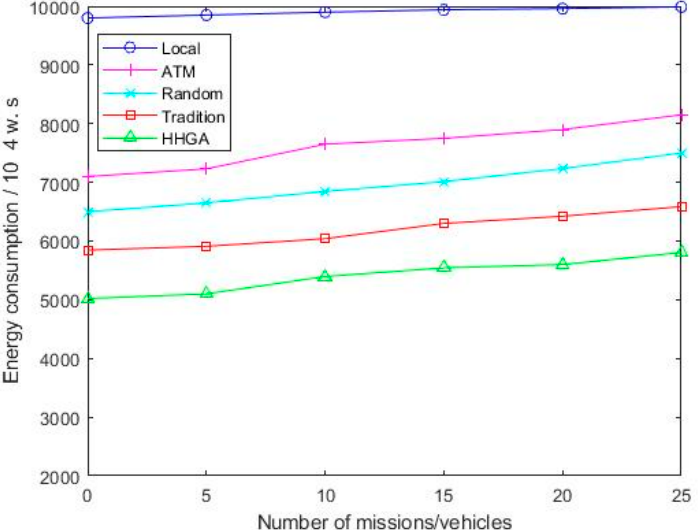
Figure 6. Comparison of energy consumption of various algorithms under different number of tasks.